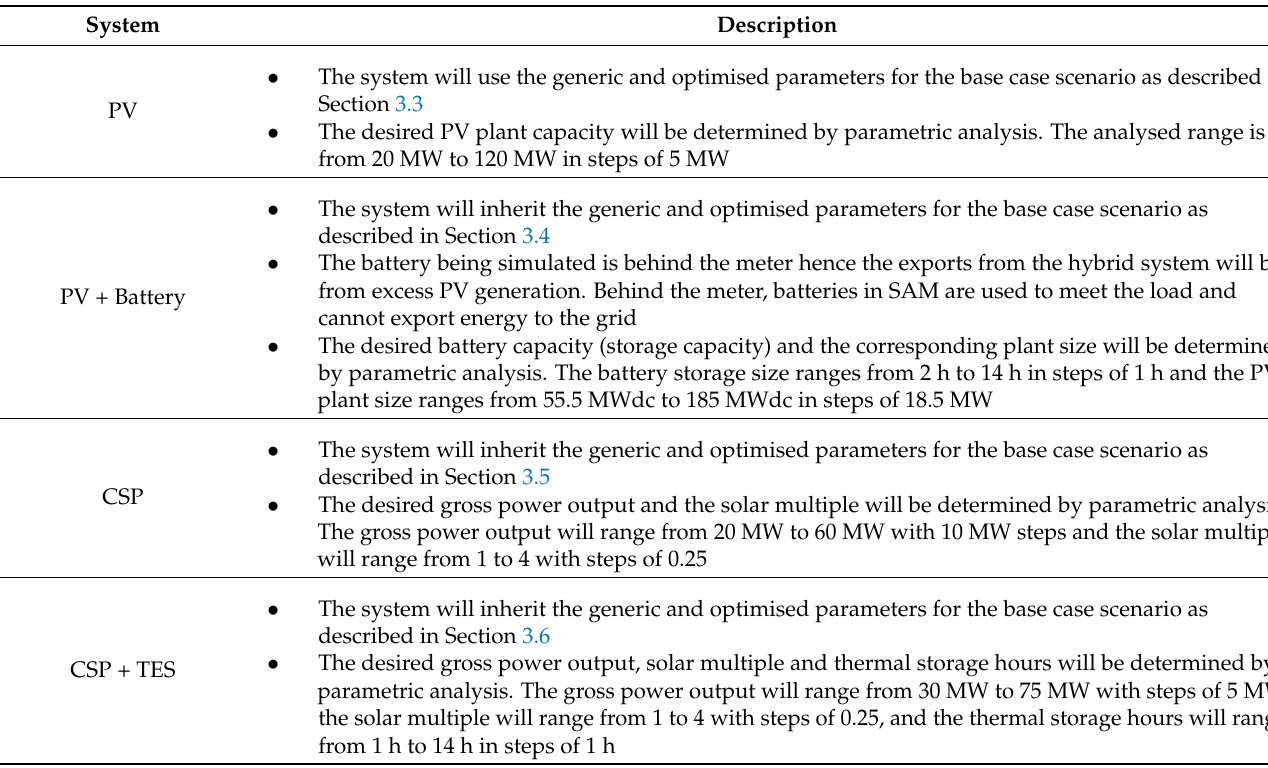
Table 13. Methodology to simulate system with